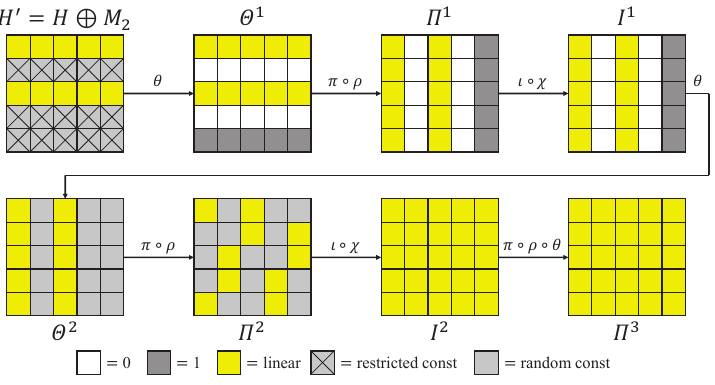
Figure 3: The 2-round linear structure in